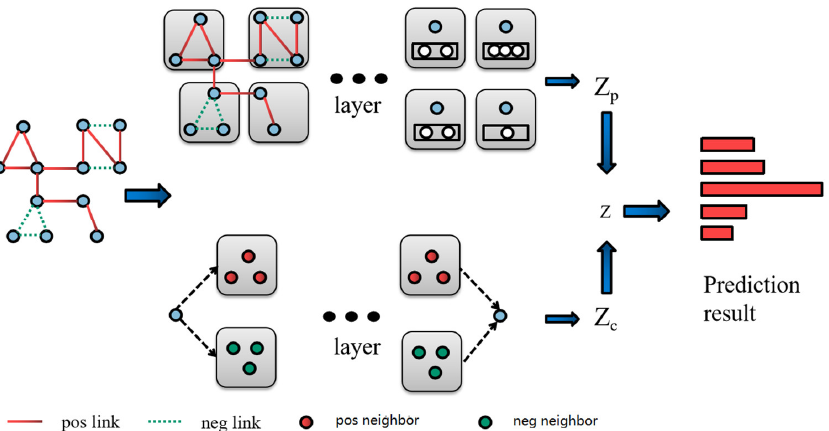
Figure 2. The framework of SHGP. Given a signed graph with positive and negative links, the lower part of the diagram shows the process of local feature convolution through two types of aggregators, red for the friend relationship aggregator and green for the enemy relationship aggregator.